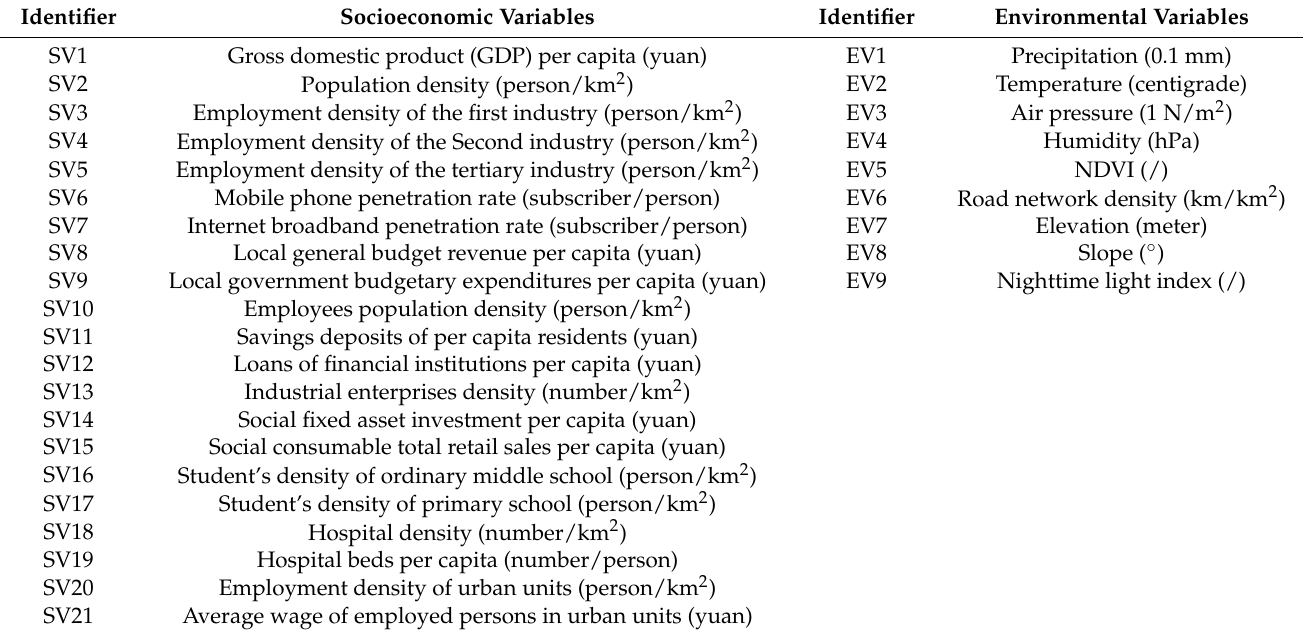
Table 1. City-level potential explanatory variables of regional tourism in China: SV1-21 denote twenty-one socioeconomic factors, and EV1-9 denote nine environmental